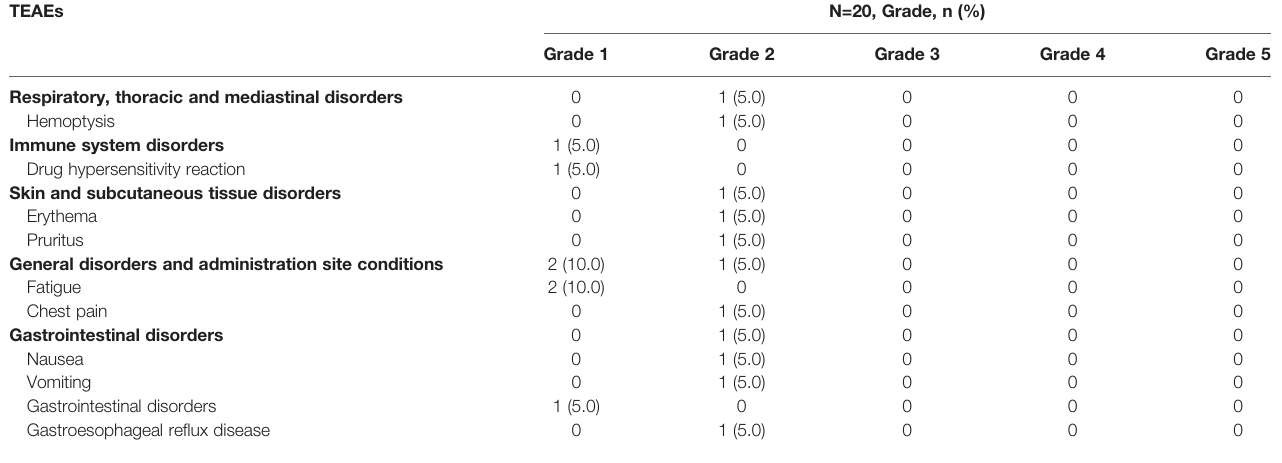
TABLE 2 | TEAEs experienced among the study population.